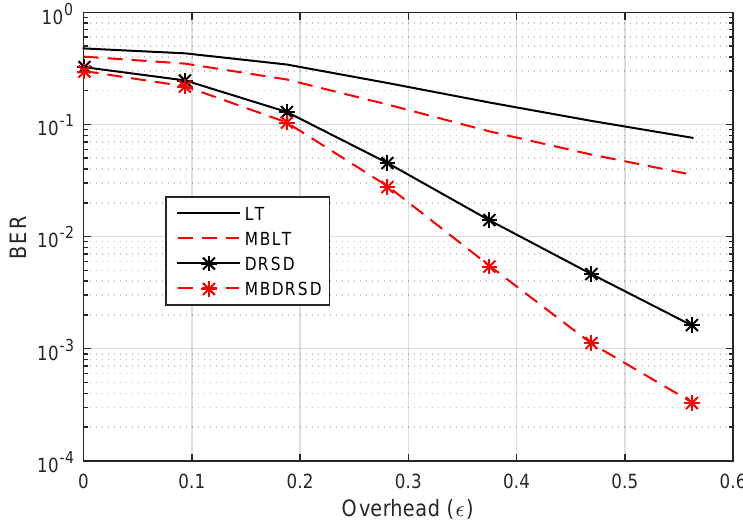
Figure 9. BER versus the overhead ( (cid:101) ) for different coding schemes at k = 128 and erasure probabili- ties of ε 1 = 0.01, ε 2 = 0.01, and ε 3 = 0.1.